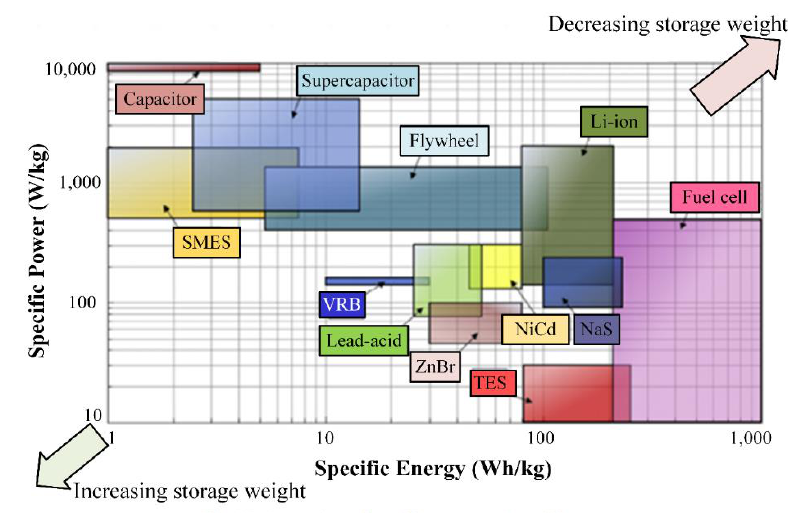
ff erent types of ESSs [26].